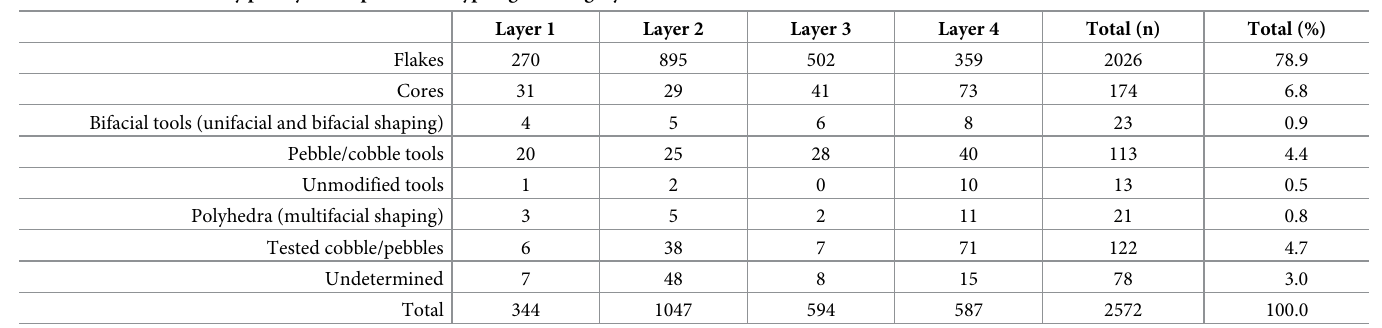
Table 1. Artifact inventory per layer and per techno-typological